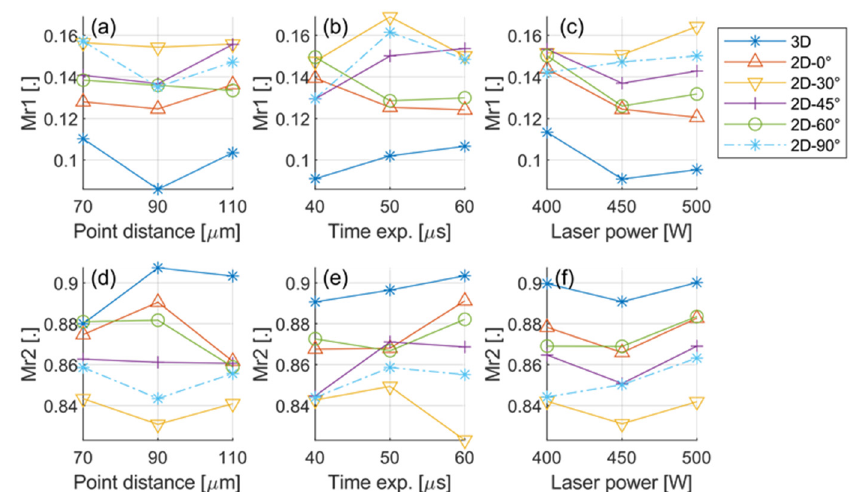
Figure 7. Influence of process parameters on ( a – c ) Mr1 and ( d – f ) Mr2. Effect of ( a , d ) point distance, ( b , e ) time exposure (exp.) and ( c , f ) laser